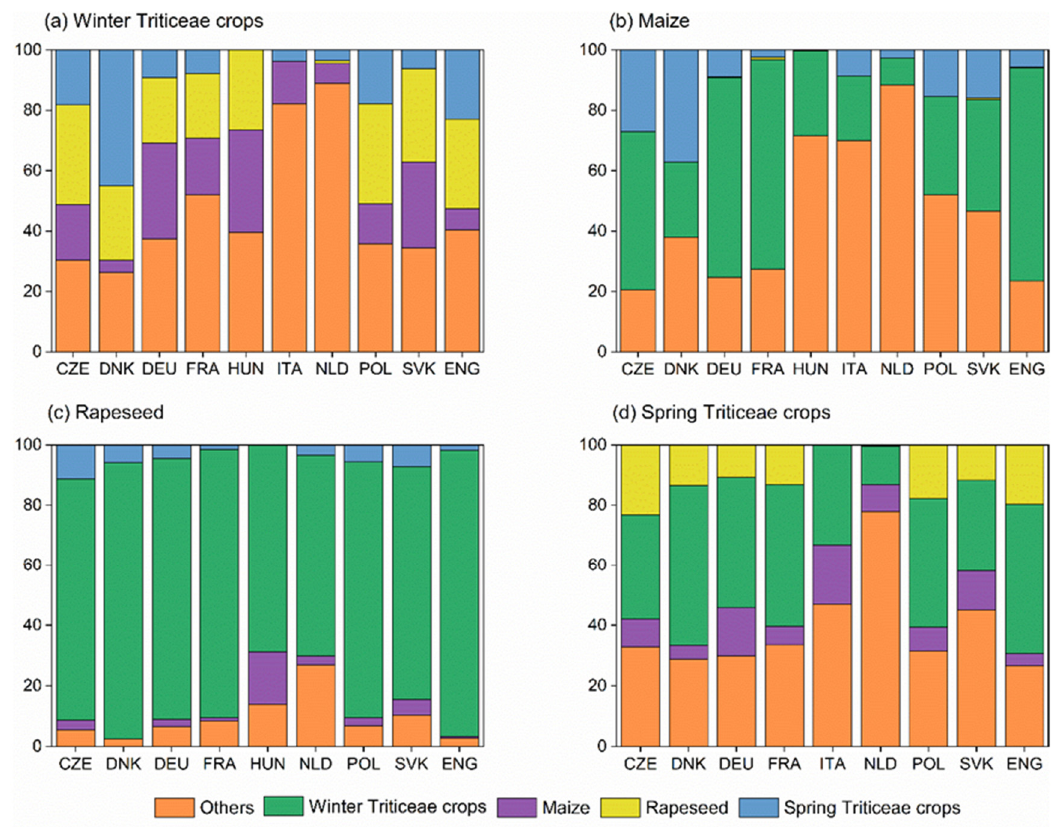
Figure 9. Spatial details of rotation patterns in France ( a , c ), Germany ( b ), and England ( d ) from 2018 to 2019 for maize, winter Triticeae crops, rapeseed, and spring Triticeae crops.